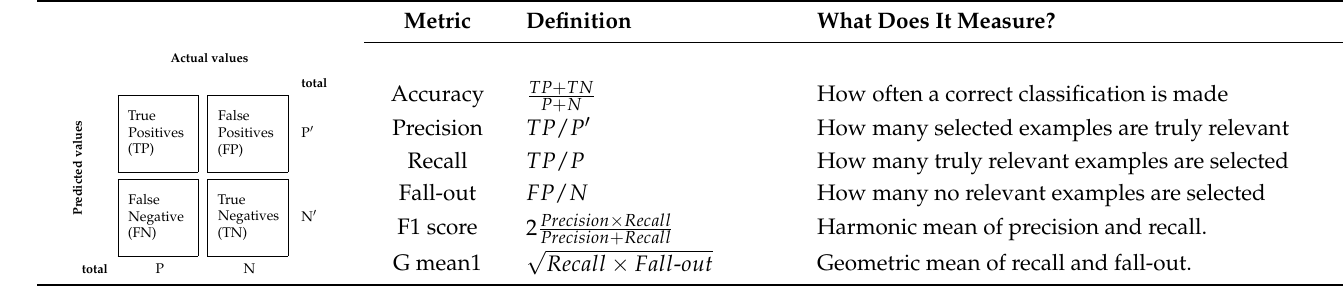
Table 2. Confusion matrix for a binary classifier and its consequent standard performance metrics. In general, to have a complete view of the classifier, it is suitable to draw on, at least, accuracy, precision, recall, and fall-out. The F1 score and G mean1 are useful metrics for imbalanced multilabel classifications, and they also give important moderation features that help in model evaluation. Each metric has its probabilistic interpretation.